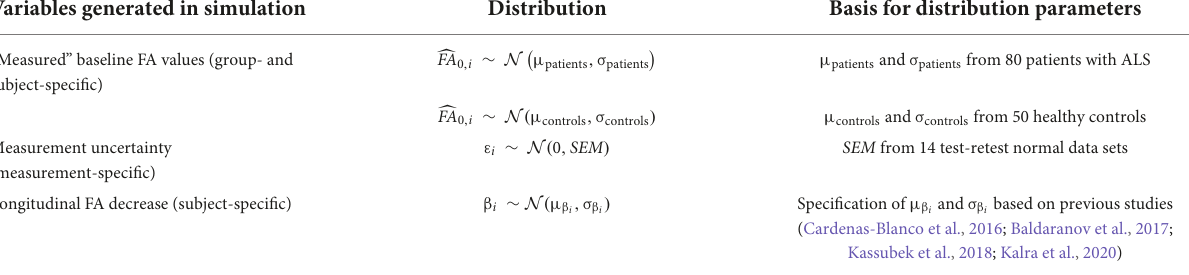
TABLE 1 Description of the distributions used for longitudinal group data